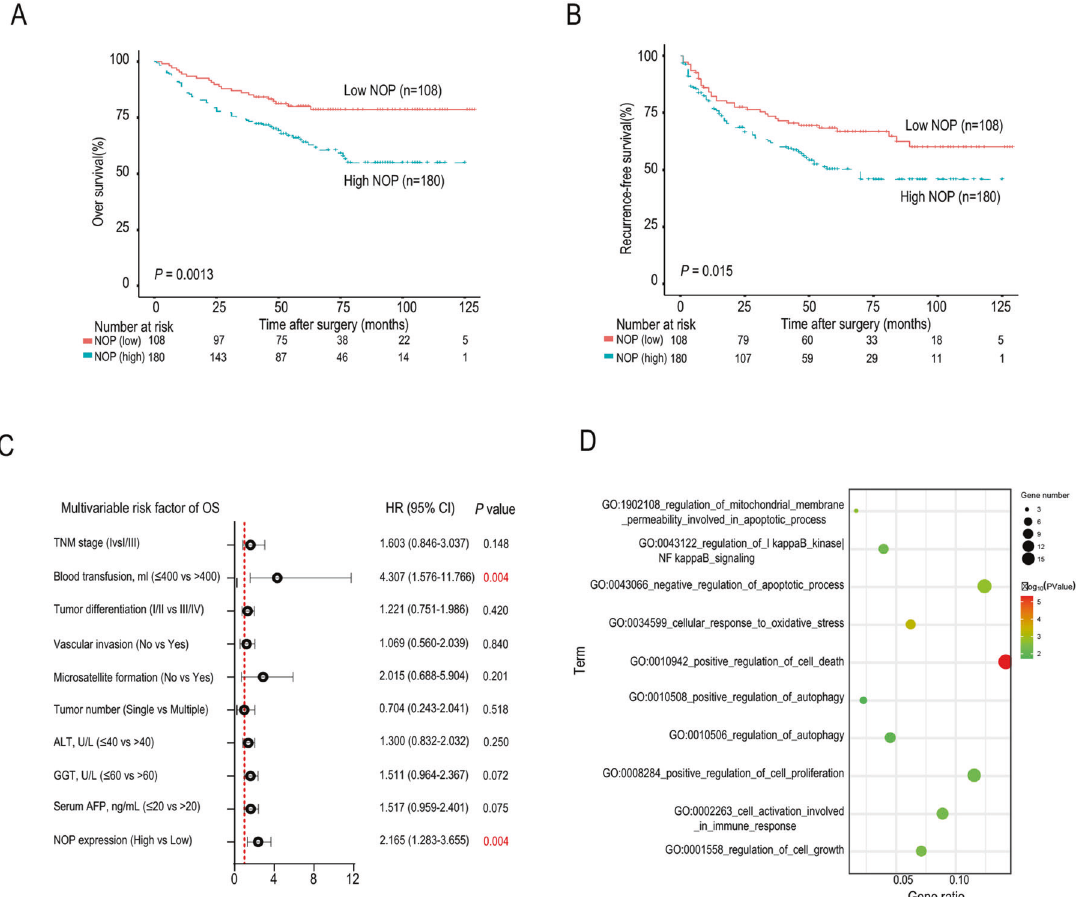
Fig. 2 NOP predicts poor prognosis in HCC. A , B Kaplan – Meier analysis based on NOP expression in the SYSUCC cohort. C Forest plot showing prognostic factors associated with overall survival ( P = 0.004). D Bubble plot of Gene Ontology analysis results for differentially expressed genes identi fi ed by